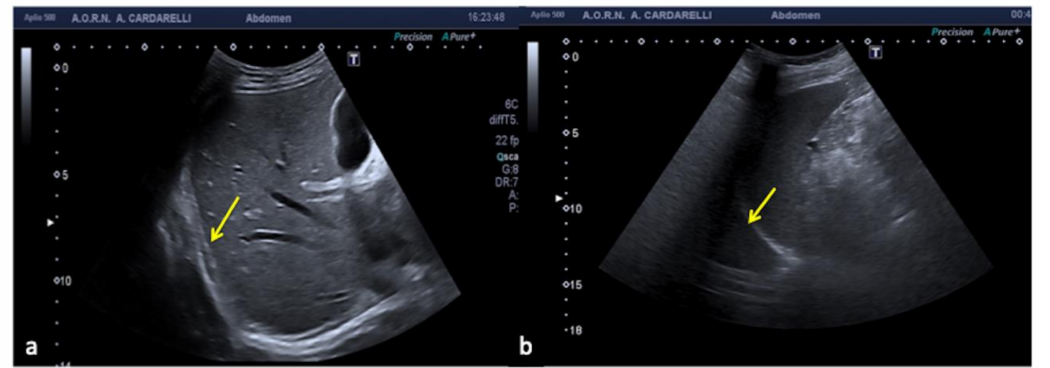
Figure 19. Longitudinal US left flank scan ( a ) shows at the lower pole of the kidney (K) a hypoe- choic area which may be misinterpreted as retroperitoneal free fluid (arrows) in a 22-year-old man investigated for trauma. On CT scan ( b ) it appears to be a spastic intestinal loop (arrow).